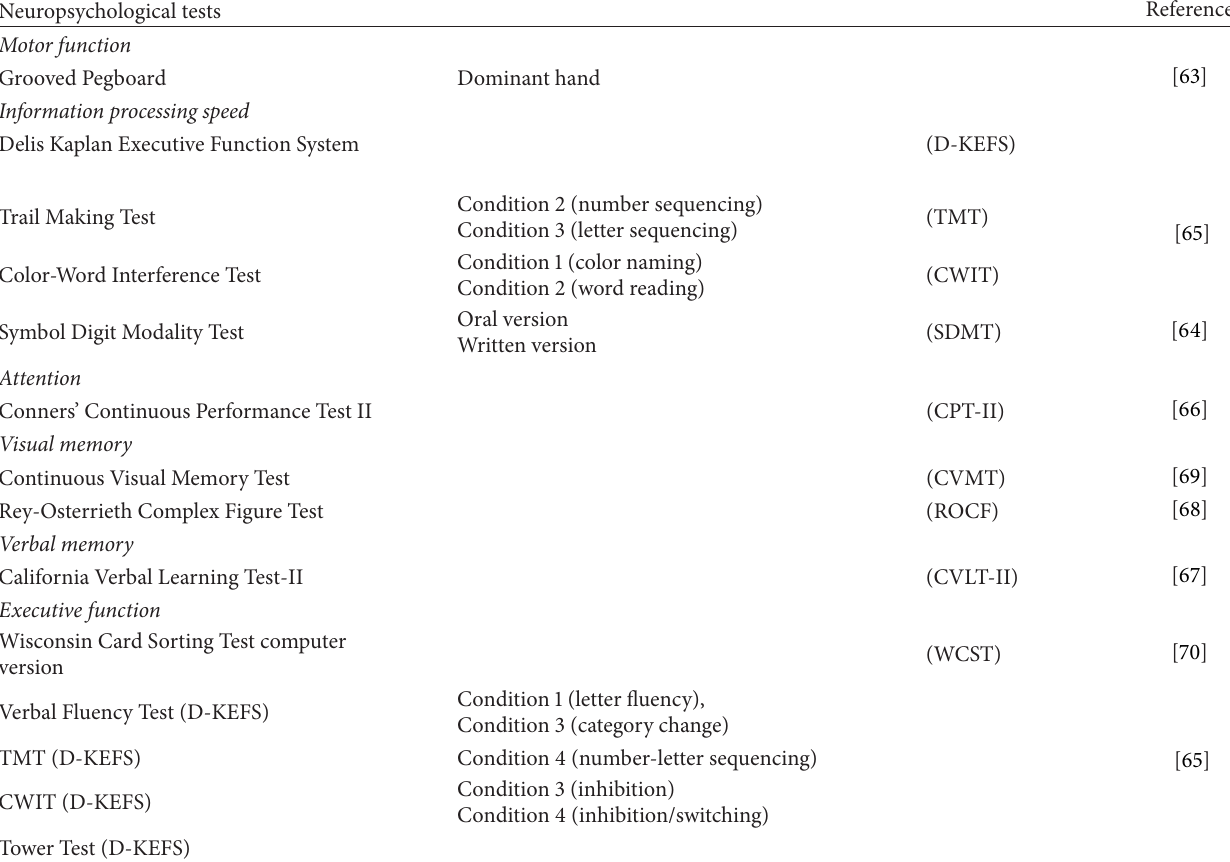
Table 1: Overview of performance-based neuropsychological tests assessing cognitive function in the subsample grouped into cognitive domains 3 months after